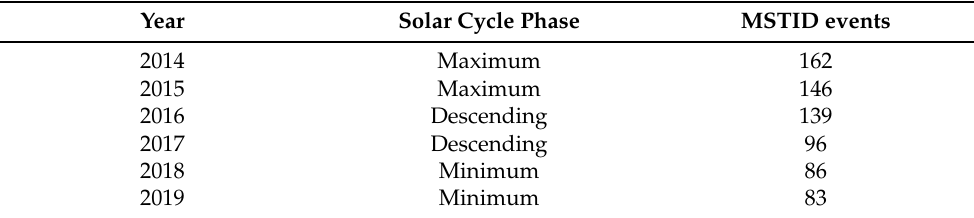
Table 1. The annual occurrence rate of MSTIDs during geomagnetically quiet conditions from 2014 to 2019.